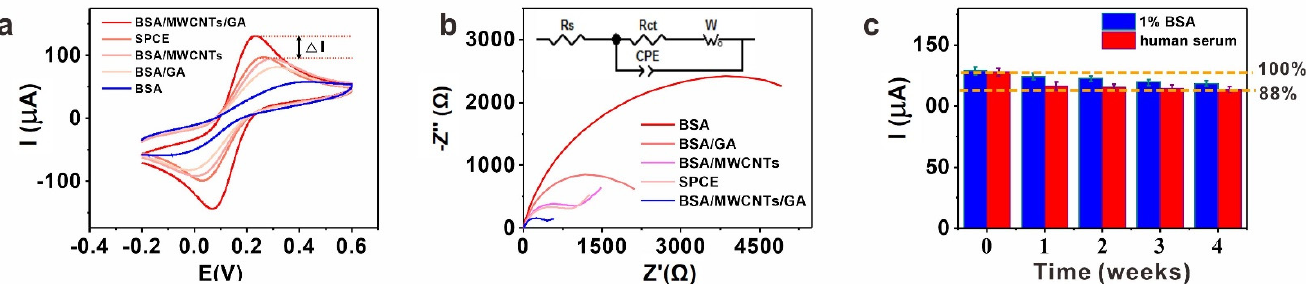
Figure 1. ( a ) The cyclic voltammetry (CV) characterization of different modified SPCEs. ∆ I% = (I BSA/MWCNTs/GA − I SPCE )/I SPCE ; (n = 3, only one CV plot for each condition is shown); ( b ) the electrochemical impedance spectroscopy (EIS) characterization of different modified SPCEs . (n = 3, only one EIS plot for each condition is shown) Inset: Equivalent circuit of impedance measurement; ( c ) the stability of BSA/MWCNTs/GA layer in 1% BSA and unprocessed human serum. (n = 3, error bars represent the standard deviation of the mean).